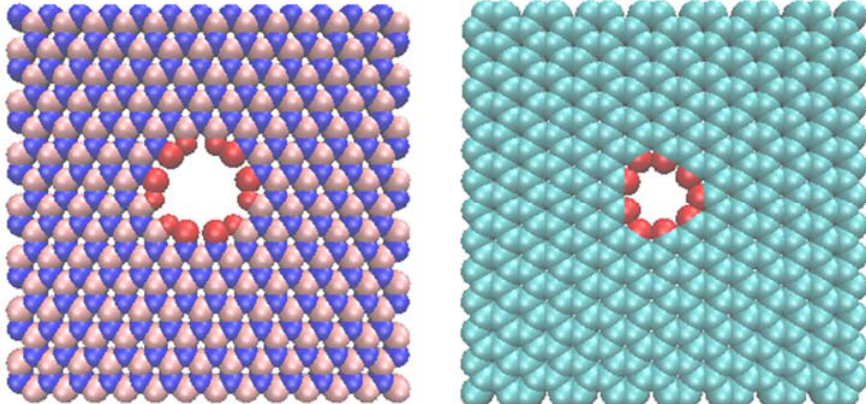
Fig. 2: Functionalized pore of membranes. Left: BNNS and right is GNS (blue represents nitrogen, silver is boron, cyan is carbon and red is fluoride).